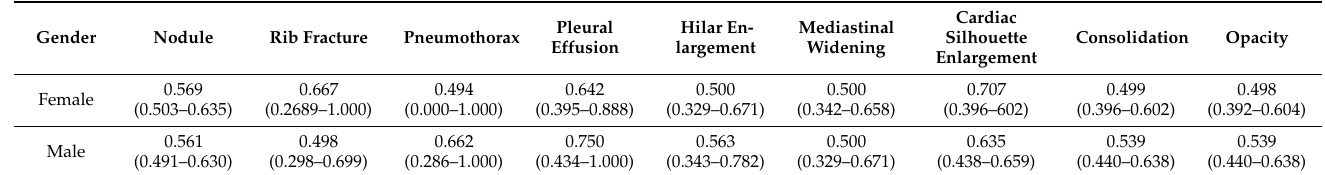
Table 5. Variations in the AI algorithm’s performance for detecting different radiographic findings based on patients’ stated gender (female versus male patients). Table represents area under the curve with 95% confidence intervals in parentheses.